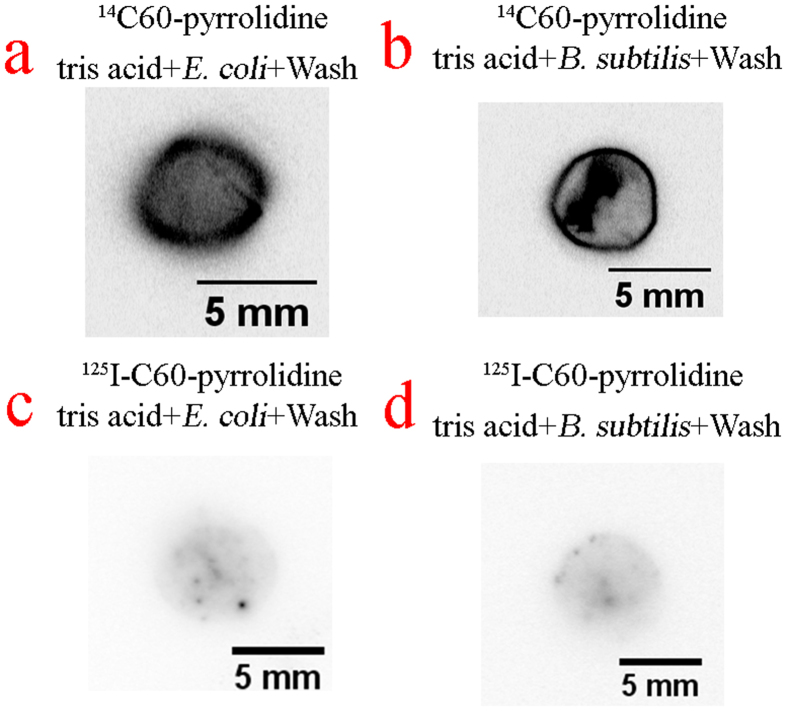
Cellular uptake of radiotracers labelled C60-pyrrolidine tris acid by microorganisms monitored by Autoradiography.(a) and (b) 14C60-pyrrolidine tris acid uptake by E. coli (a) and B. subtilis(b). (c) and (d) 125I-C60-pyrrolidine tris acid uptake by E. coli (d) and B. subtilis (d).